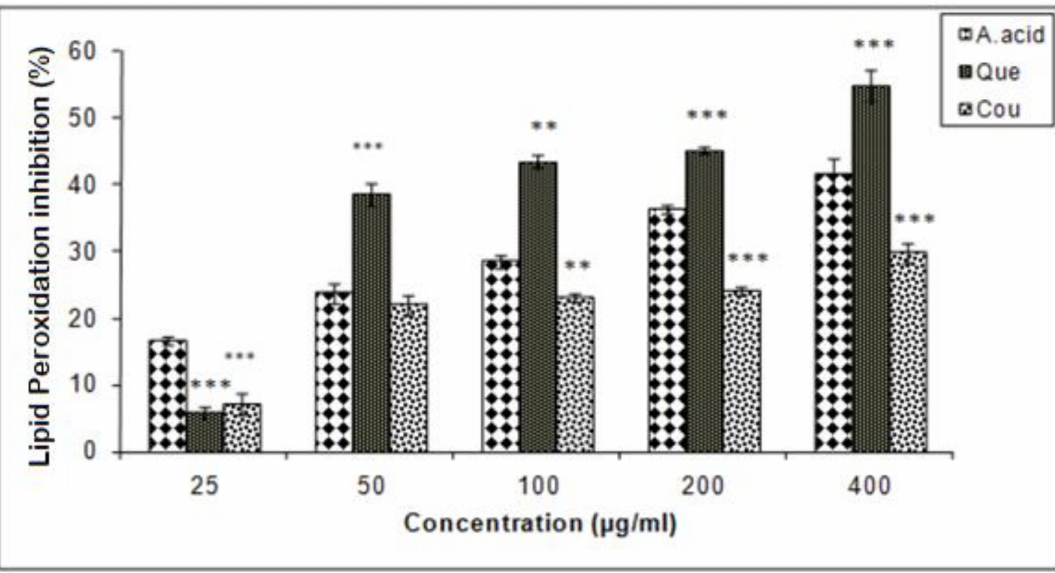
Figure 6. Hepatic lipid peroxidation inhibition activities of quercetin and coumarin as compared to the control; ascorbic acid. Each vertical bar represents the mean ± S.E.M. (n = 3). *** p < 0.001, ** p < 0.01 and * p < 0.05 as compared to the respective control values. A. acid, ascorbic acid; Que, quercetin; Cou, coumarin.